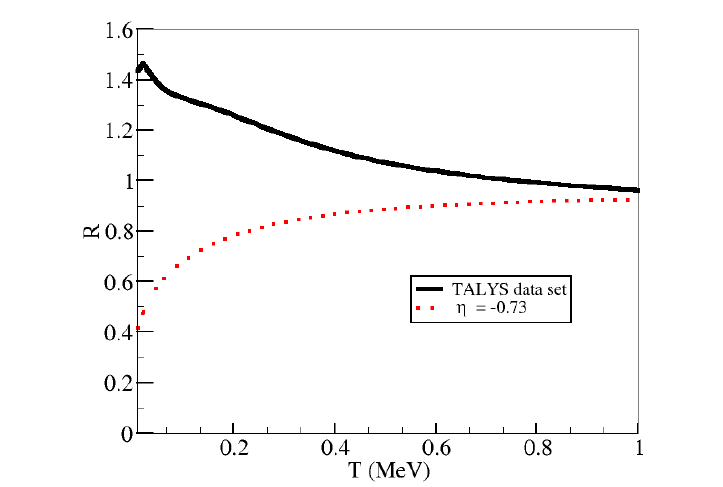
Figure 6. The same as Figure 4 but for 58